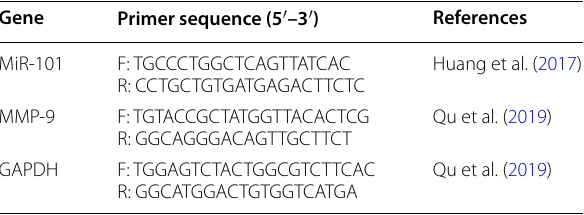
F: forward primer; R: reverse primer, metallopeptidase-9 (MMP-9), micro- RNA-101 (MiR-101)